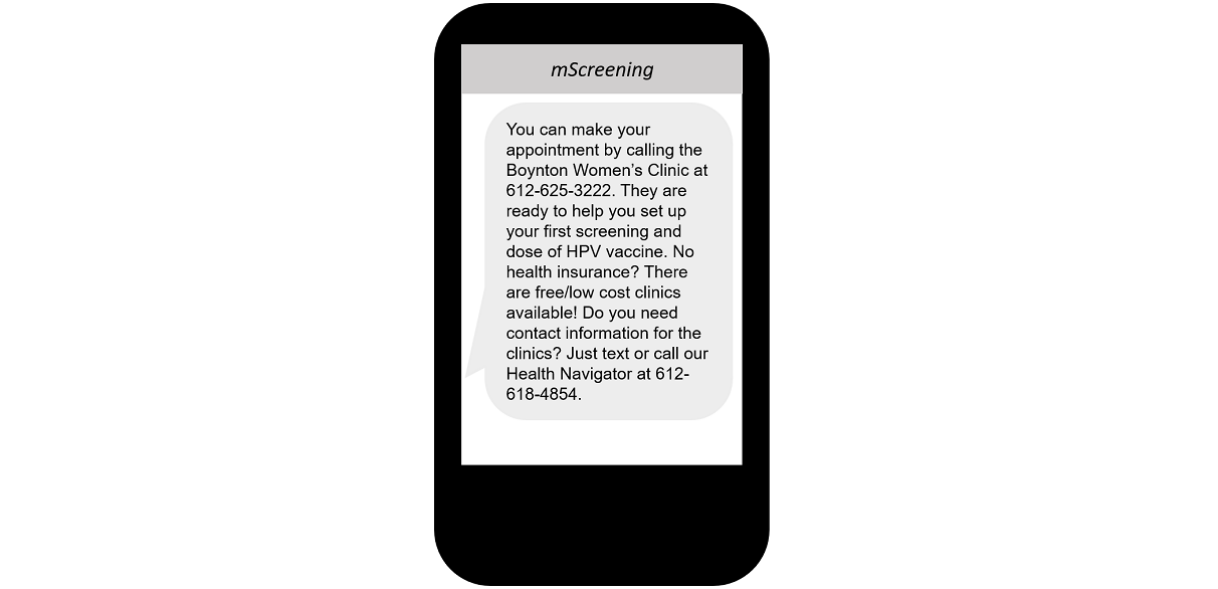
Figure 5. Mobile screening message example: included information on the price of the human papillomavirus vaccine and phone numbers of women’s clinics that employed female doctors and nurses.